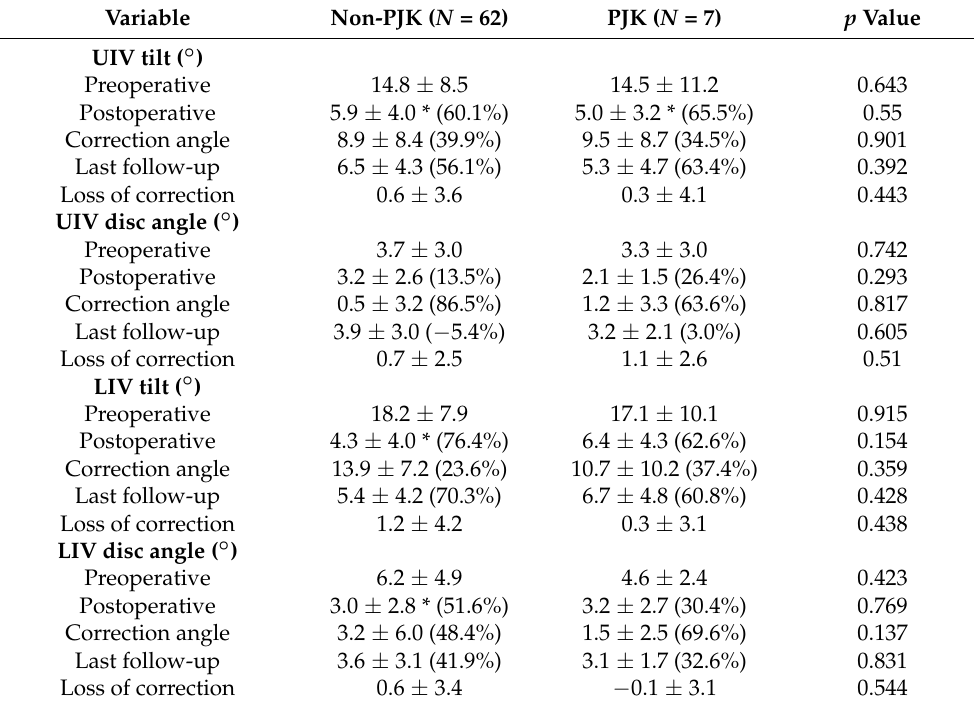
Table 3. Comparison of the tilt and disc angle of UIV and LIV between the non-PJK and PJK